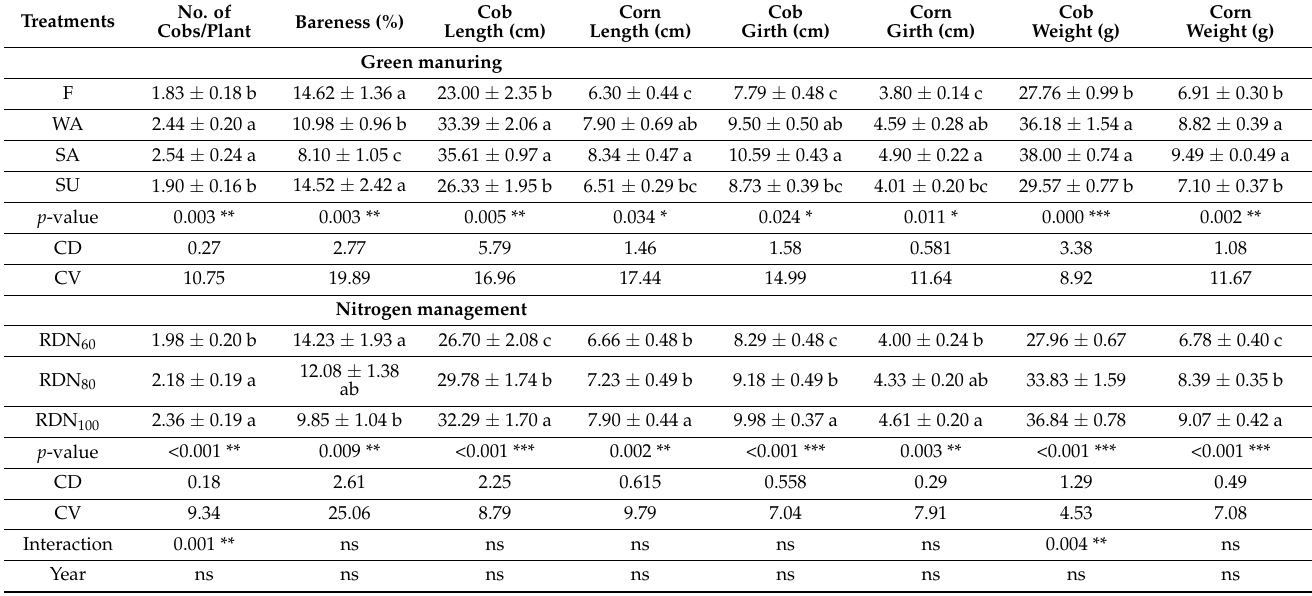
Table 3. Effect of summer green manuring and nitrogen management on yield attributes of succeeding baby